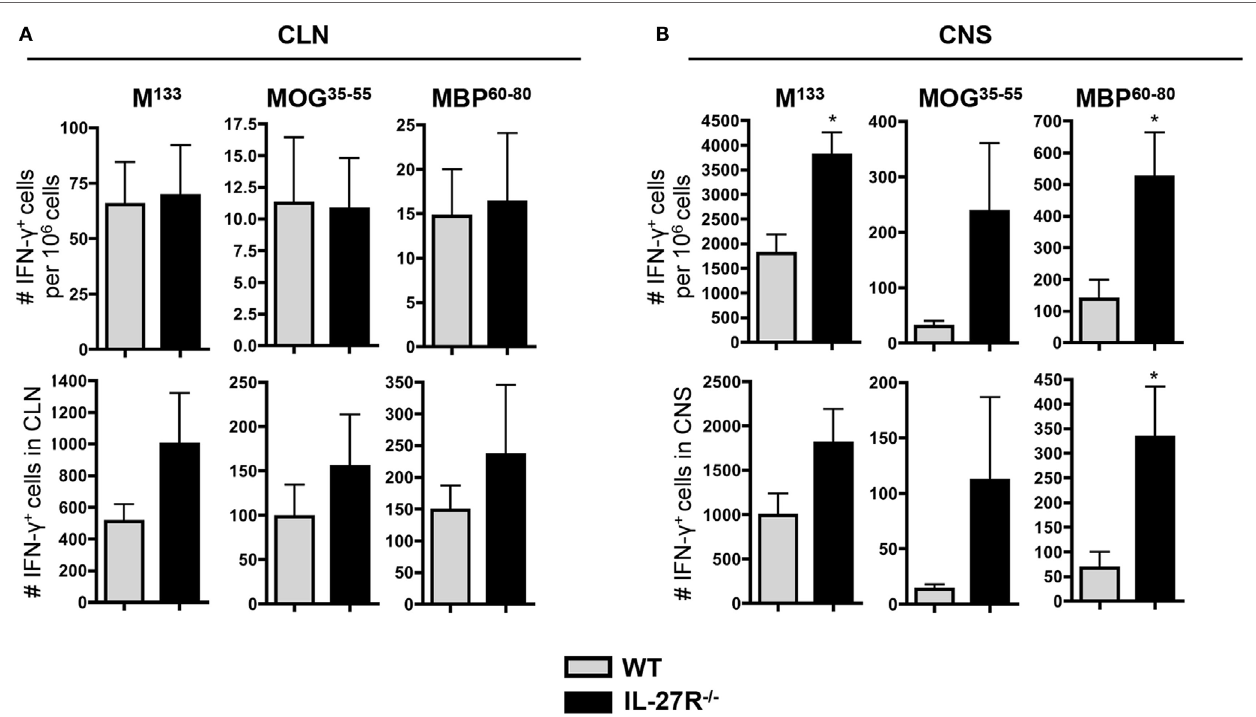
FigUre 7 | increased cns sr T cell response in absence of Tr1 cells . Frequencies and absolute numbers of virus-specific M 133 , MOG 35 − 55 , and MBP 60 − 80 specific CD4 + T cells in CLN (a) and CNS (B) derived cells from JHMV-infected WT and IL-27R − / − mice at d30 p.i. determined by ELISPOT. A number of spots detected in wells without stimulation were subtracted to exclude non-specific CD4 + T cells. Data represent the mean of two separate experiments with seven to eight pooled mice per group per experiment. * p < 0.05, Mann–Whitney